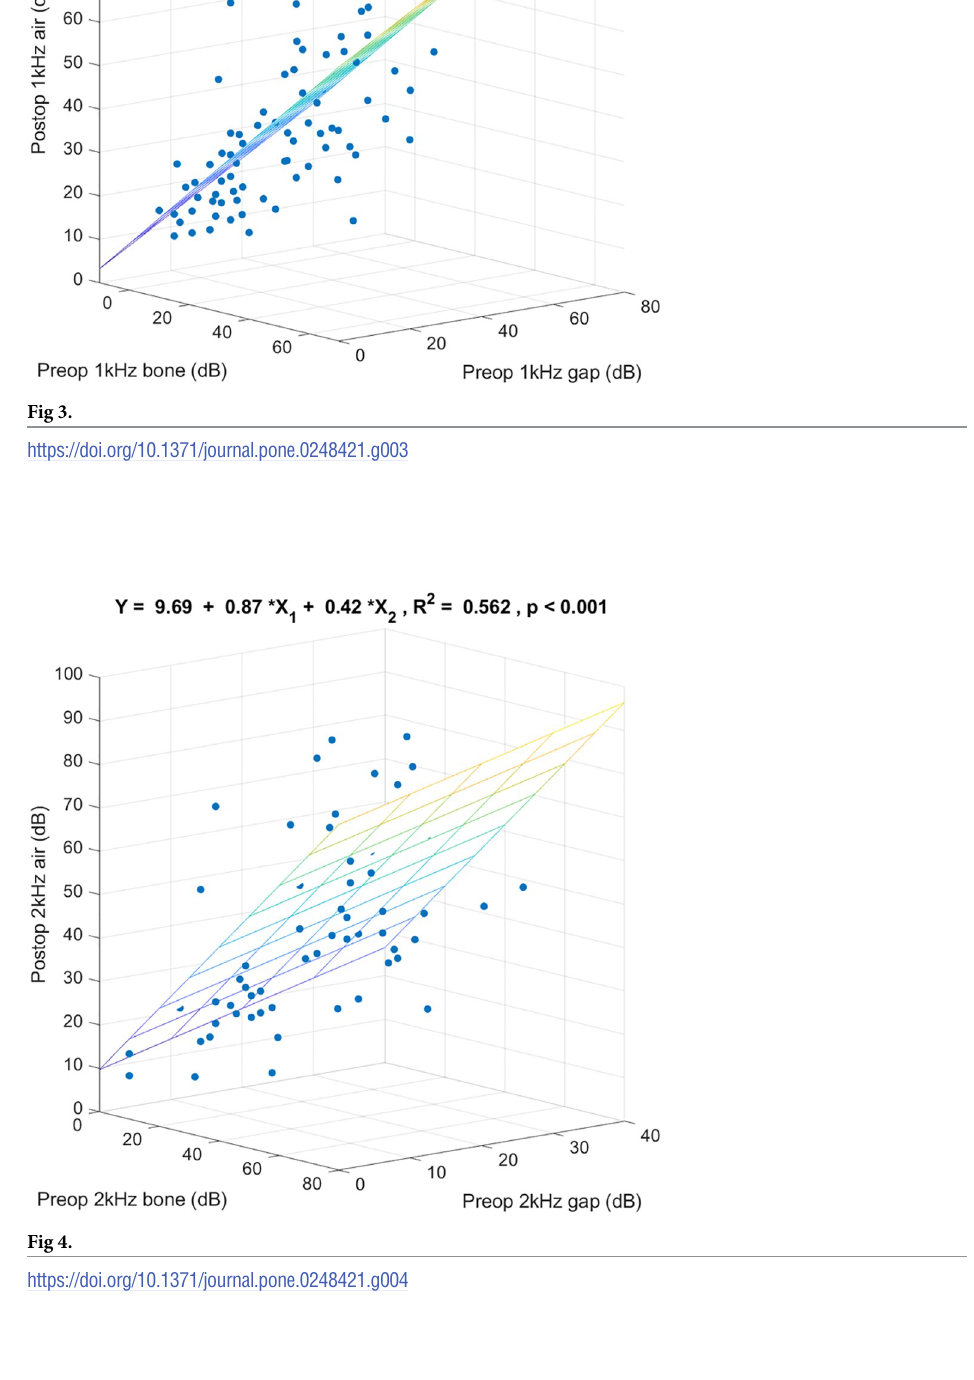
PLOS ONE | https://doi.org/10.1371/journal.pone.0248421 March 11,